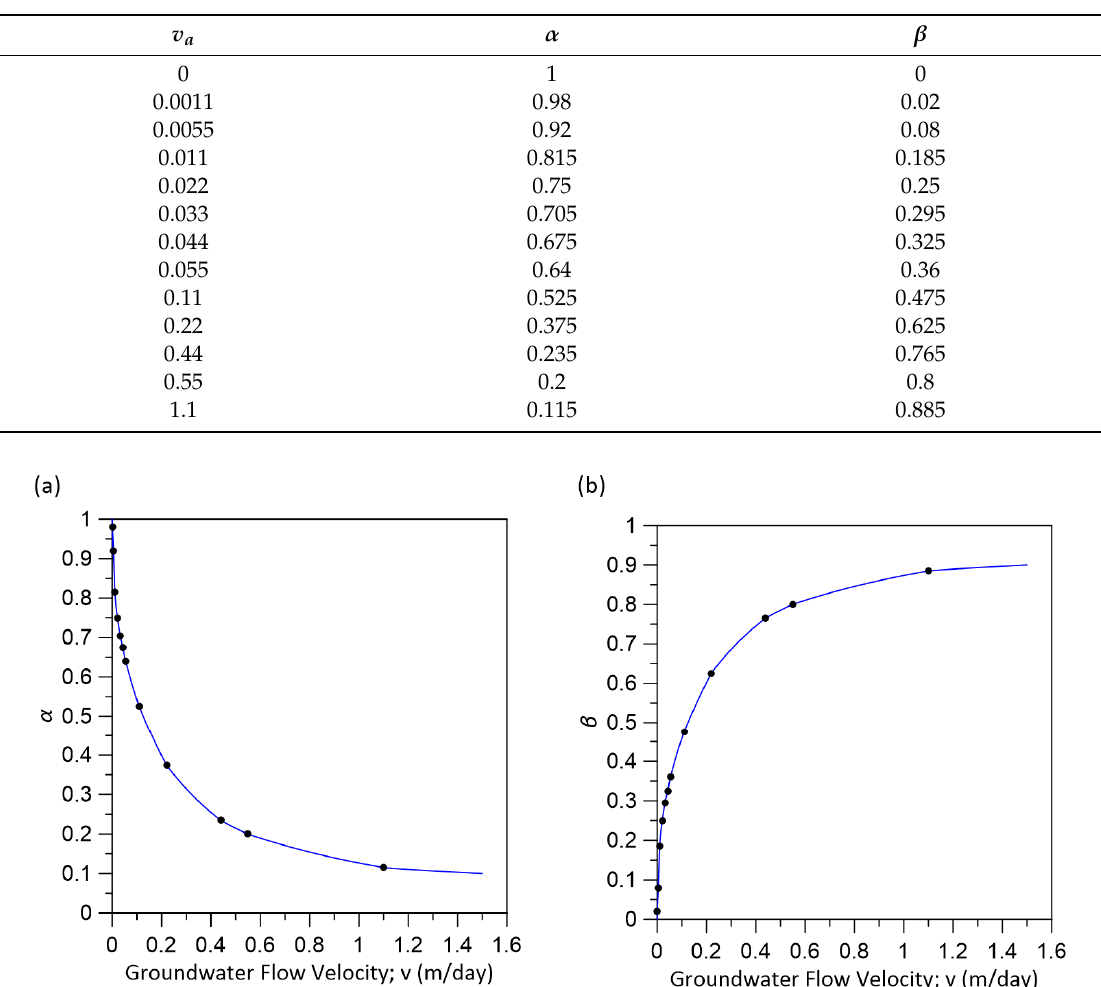
Figure 8. Distribution of the subsurface temperature profile and GHE simulation result of the model. The temperature profile was set as ( a ) 15 °C, ( b ) with a temperature gradient of 0.04 °C/m, ( c ) temperature gradient of − 0.04 °C/m, ( d ) 13 °C from top to 50 m depth and 17 °C from 50 to 100 m